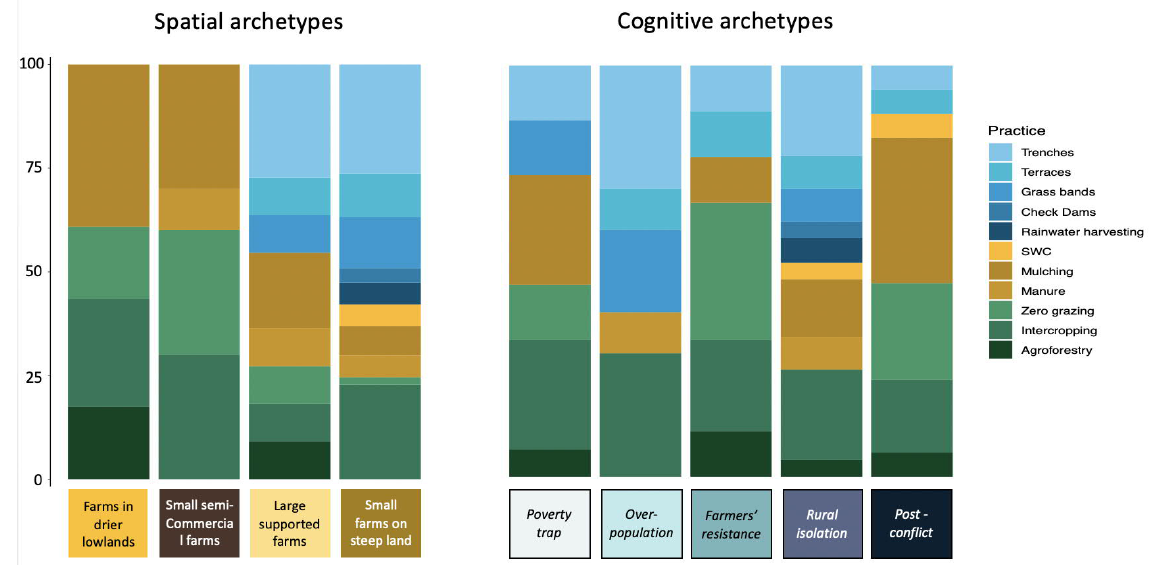
Figure A1.1. Distribution of sustainable land and water management (SLWM) practices across four spatial and five cognitive archetypes in Uganda. The practices are color-coded according to their purposes: soil erosion reduction (blue shades), soil rehabilitation (yellow shades) and increased productivity (green shades). The information on the practices was recorded during the